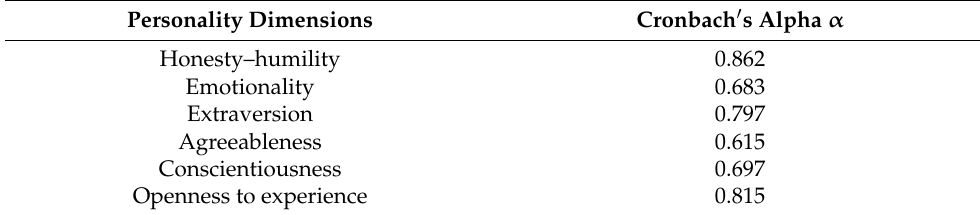
Table 1. Internal consistency of the HEXACO-60 scales in self